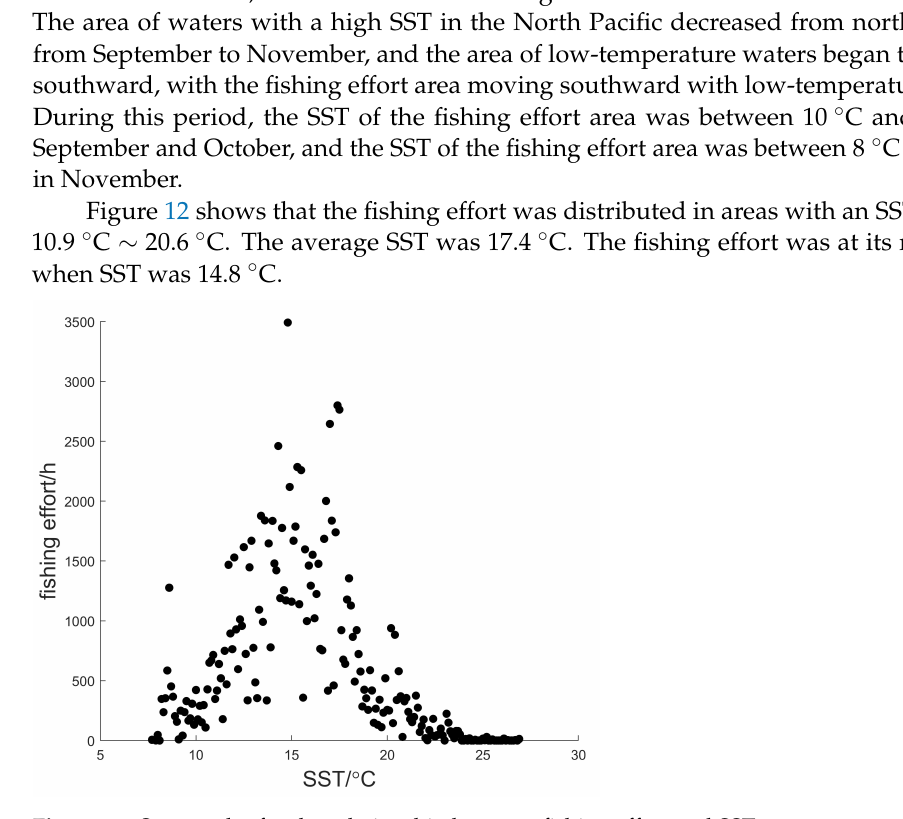
Figure 12. Scatter plot for the relationship between fishing effort and